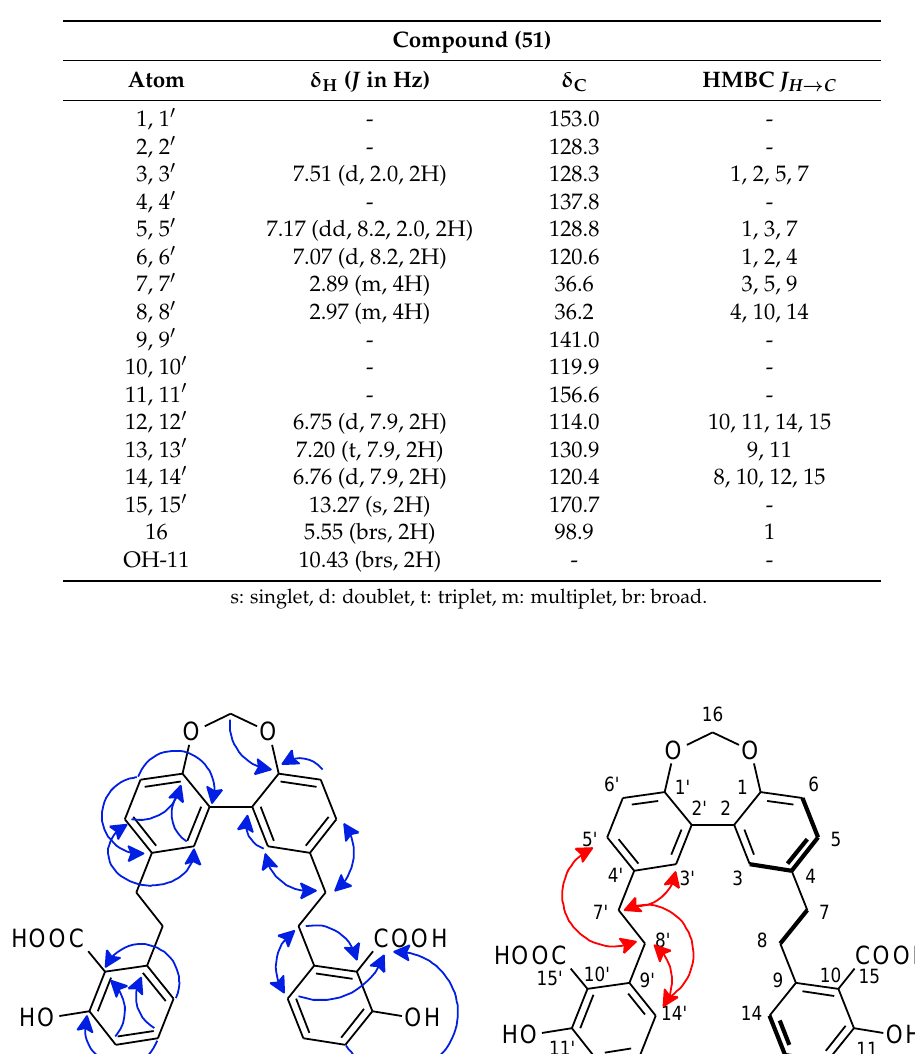
Table 2. NMR data of compound ( 51 ) in DMSO-d6 at 300 K ( 1 H at 600 MHz, 13 C at 150 MHz).